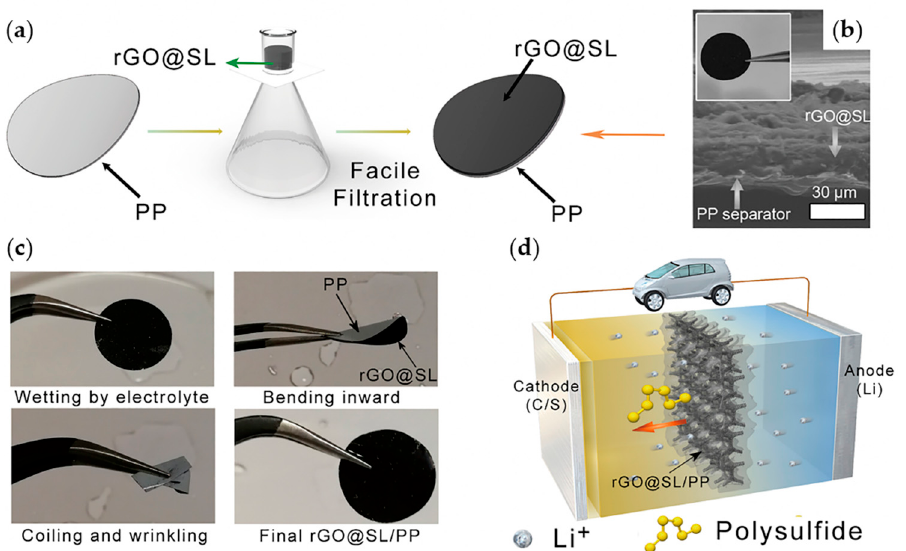
Figure 12. ( a ) Schematic of the fabrication procedure of the rGO@SL/PP separator ( b ) SEM image of